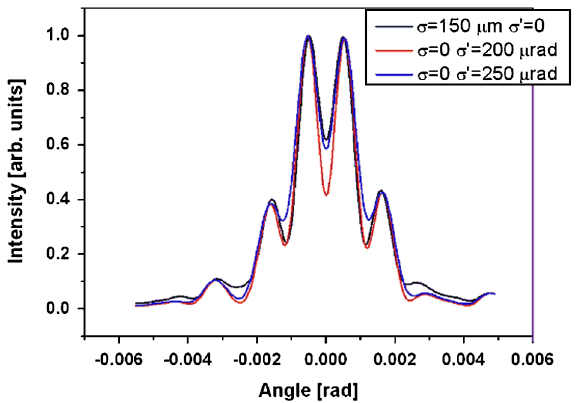
FIG. 5. Angular distribution produced by three different beams passing through a system of two noncollinear slits: a parallel beam with a size of 150 (cid:3) m (black curve), a pointlike beam with angular divergence of 200 (cid:3) rad (red curve), and a pointlike beam with angular divergence of 250 (cid:3) rad (blue